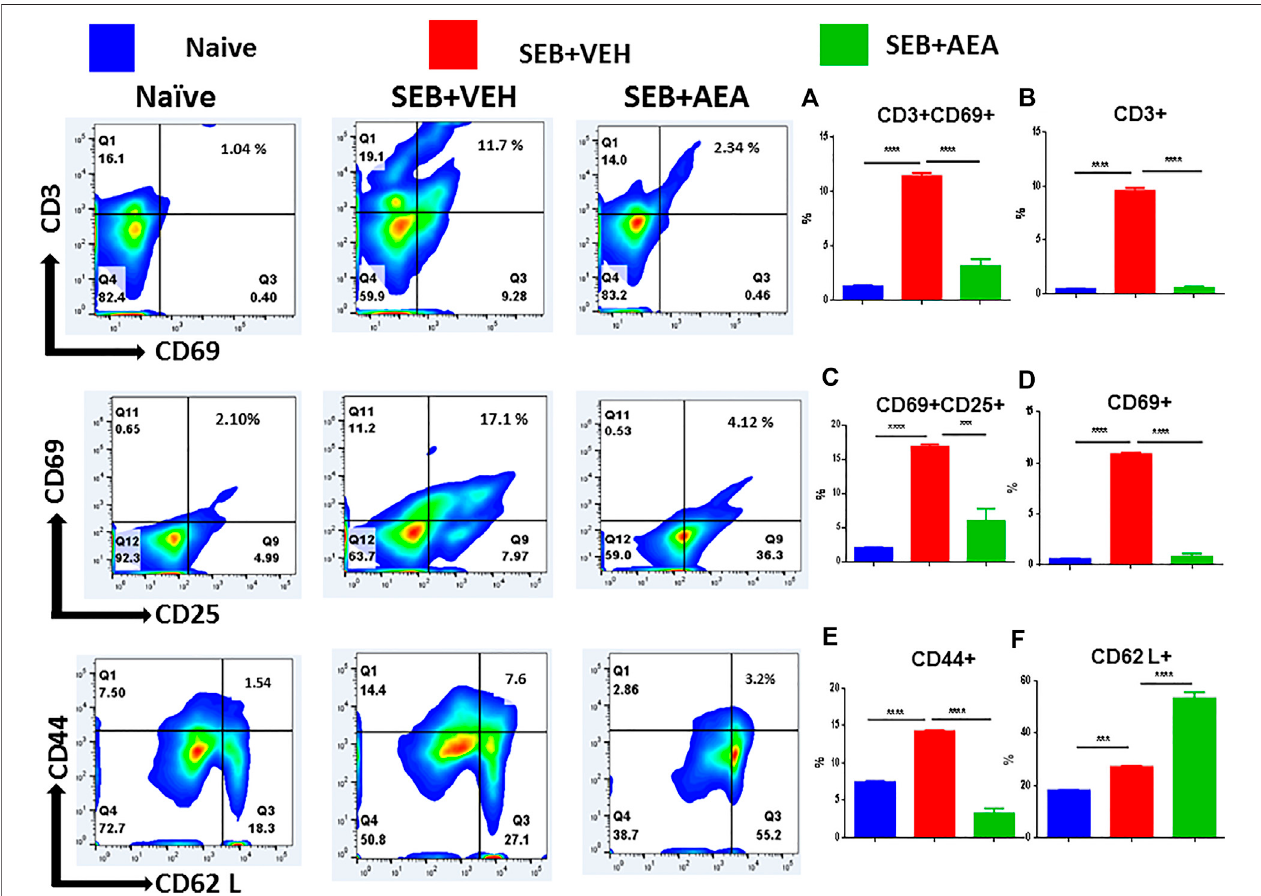
FIGURE 4 | AEA suppresses T cell activation markers in splenocytes activated with SEB. The spleen cells were pretreated with AEA and then activated with SEB in vitro for 48 h as described in Figure 3 legend. The cells were stained for various activation markers. Each panel shows a representative experiment using fl ow cytometry, and the vertical bars depict percentage data from groups of fi ve mice with Mean+/-SEM. (A) CD3 + CD69 + cells, (B) CD3 + cells, (C) CD69 + 25+ cells, (D) CD69 + cells, (E) CD44 + cells, (F) CD62L + cells. * p ≤ 0. 05, ** p ≤ 0. 01, *** p ≤ 0. 001.